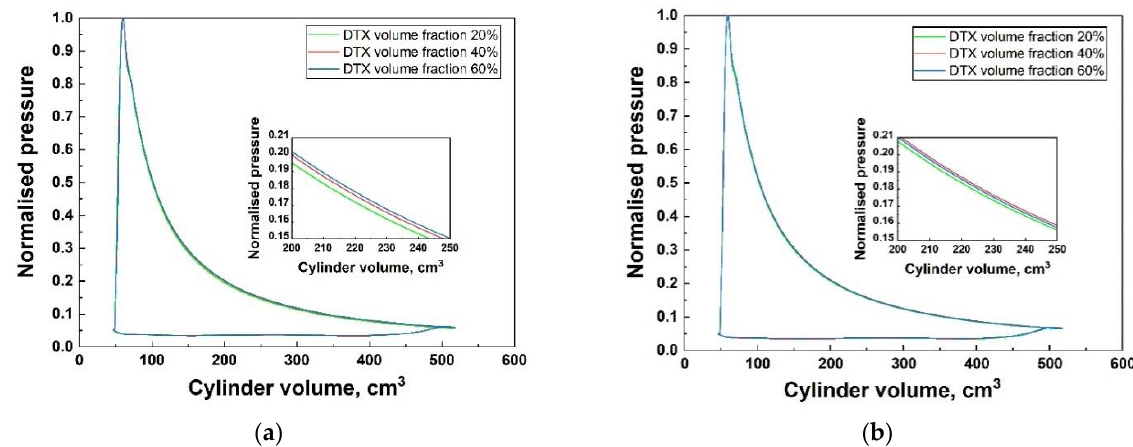
Figure 7. Brake power at different engine speeds: ( a ) 𝑁 = 600 rpm and ( b ) 𝑁 = 700 rpm .